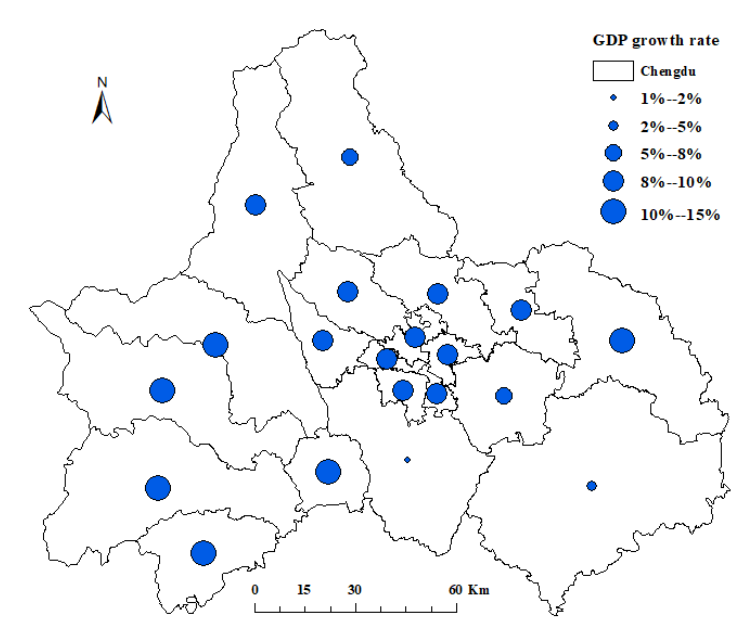
Figure 10. The quantitative analysis of GDP growth rate from 2015 to 2019.